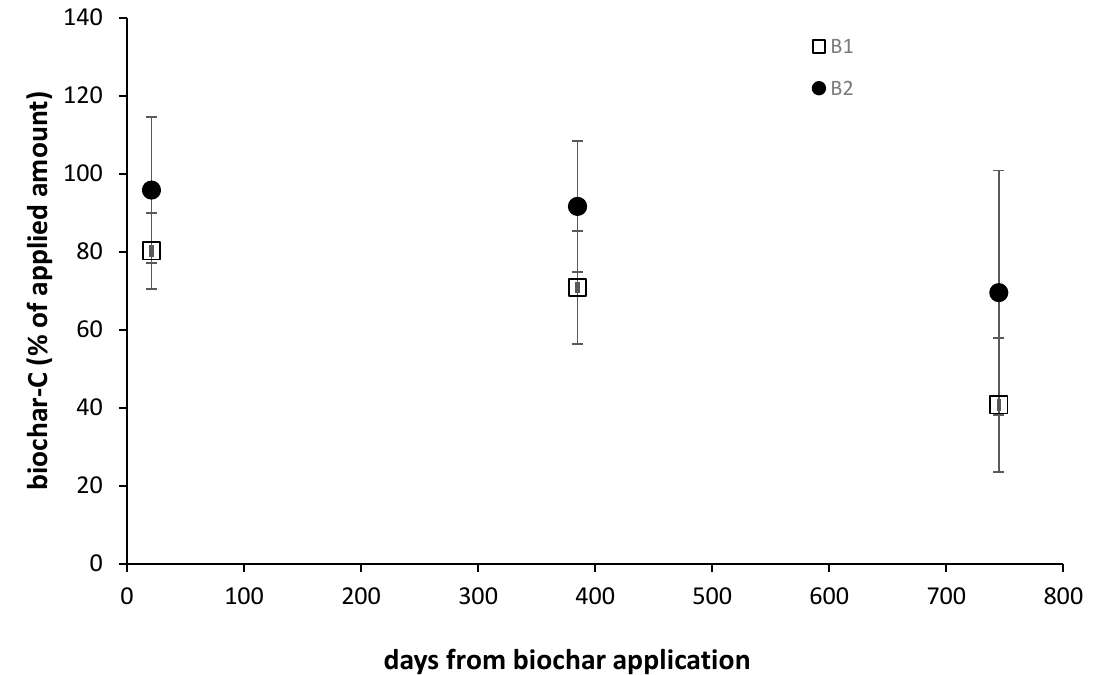
Figure 1. Biochar-C in soil (% of the applied amount) at 21 (t1), 385 (t2), and 745 (t3) days after application of biochar in treatments B1 (25 t ha − 1 of biochar) and B2 (50 t ha − 1 biochar). Values shown in the graph are the results of the isotopic mass balance approach. The vertical bars represent the standard error of the mean.